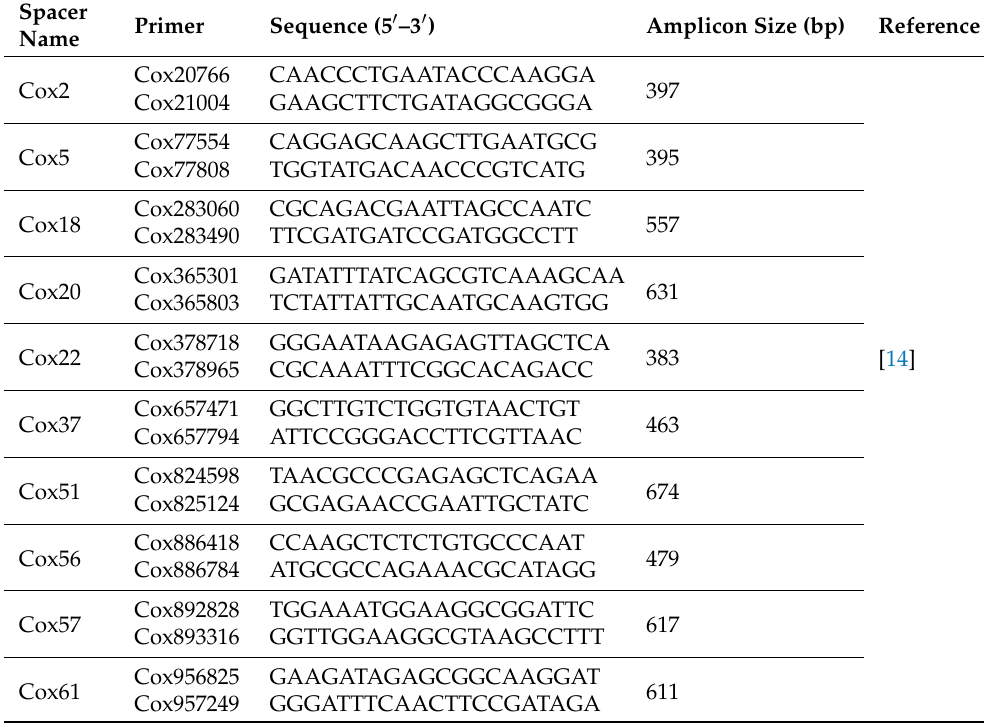
Table 2. Primers for multispacer sequence typing